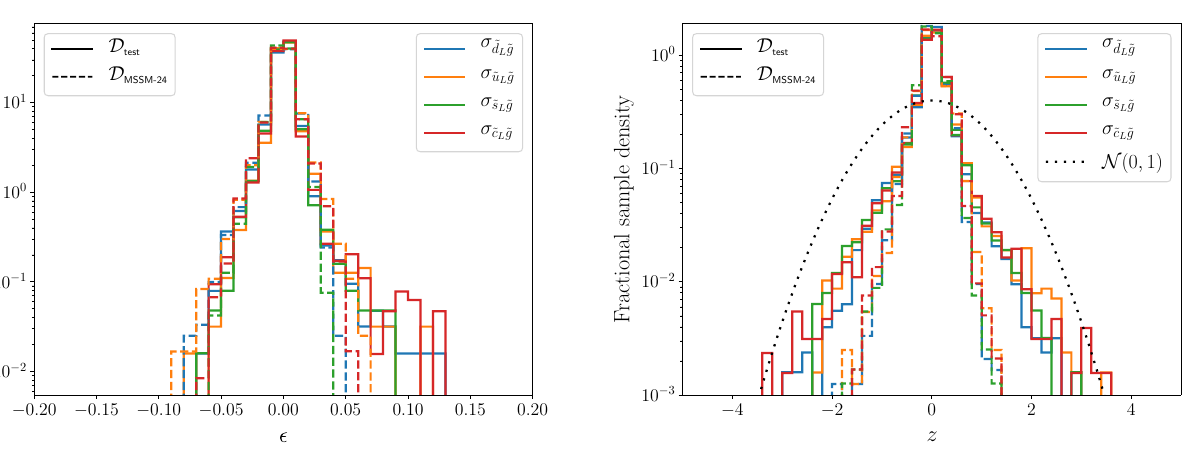
malised to unity. The unit normal distribution is shown as a dotted black line for comparison to the residual